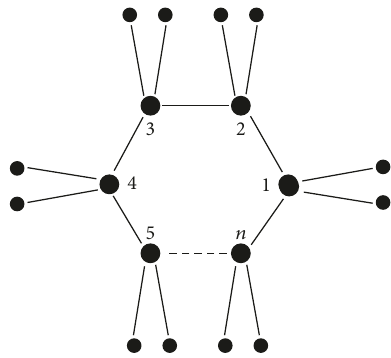
Figure 5: The molecular structure of cycloalkanes 𝐶 2 𝑛 .